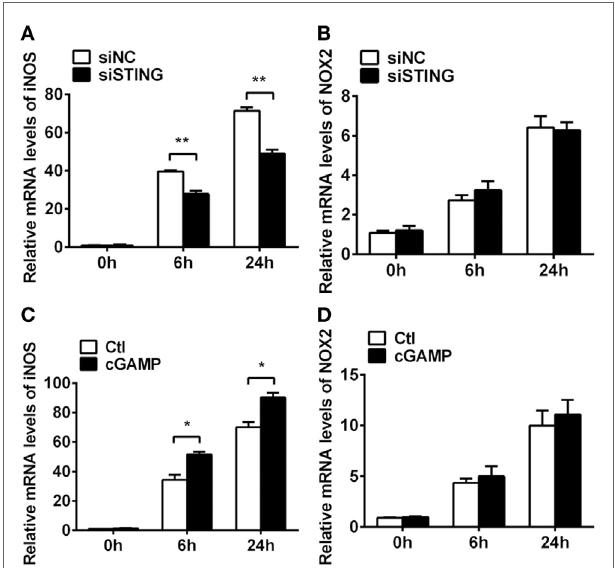
FigUre 9 | Stimulator of interferon genes (STING) induced inducible NO synthase (iNOS) expression. (a,B) mRNA levels of iNOS (a) and nicotinamide adenine dinucleotide phosphate oxidase 2 (NOX2) (B) were measured by using real-time PCR at 6 h and 24 h postinfection (p.i.) in RAW264.7 cells after treatment with siRNA for mouse STING (siSTING) versus siNC. (c,D) mRNA levels of iNOS (c) and NOX2 (D) were measured by using real-time PCR at 6 and 24 h p.i. in RAW264.7 cells after treatment with 2 ′ ,3 ′ -cGAMP (cGAMP) versus control. Data are shown as mean ± SEM of three independent experiments. * P < 0.05; ** P <